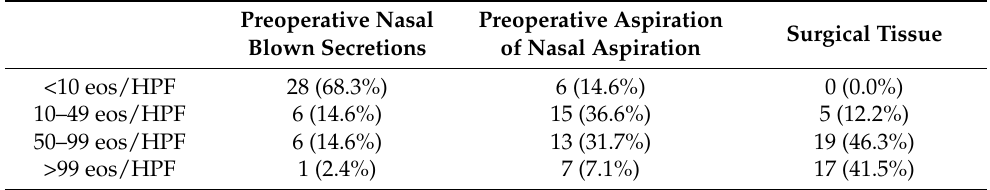
Table 2. Eosinophil count of patients with T2 inflammation included in the first experiment for the three different sampling methods.